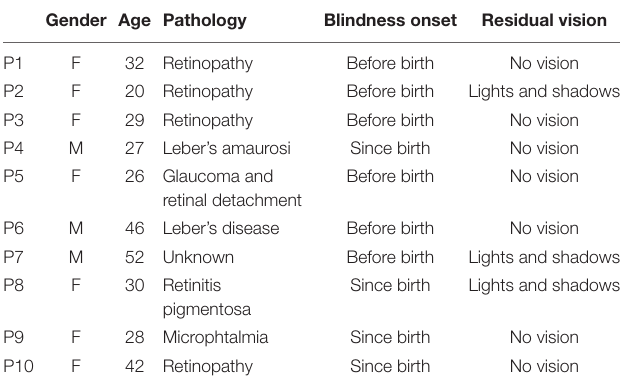
TABLE 1 | Clinical details of blind participants. Gender Age Pathology